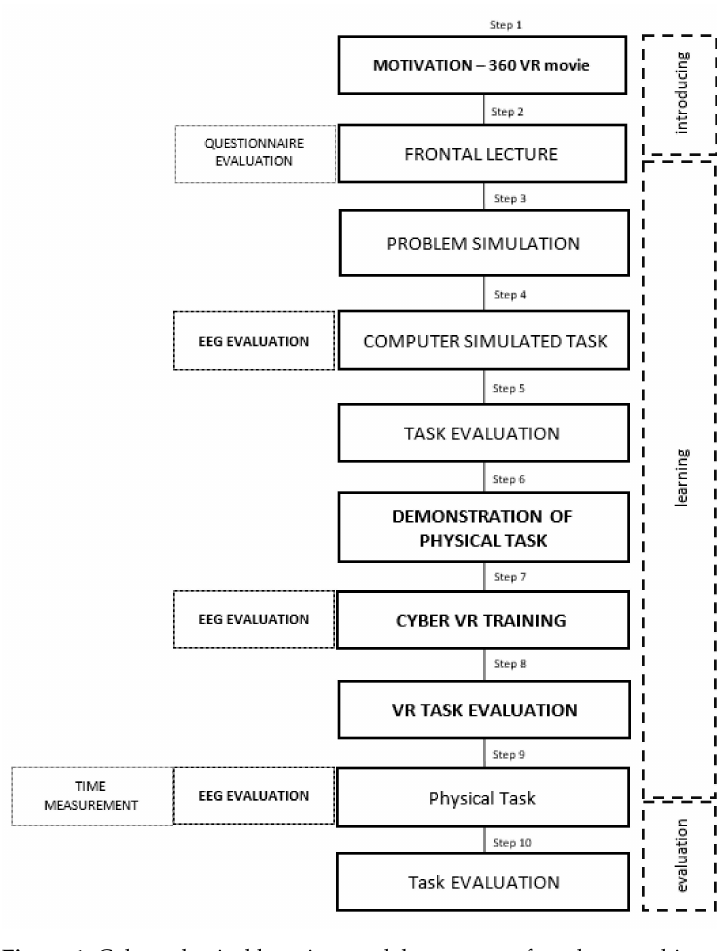
Figure 1. Cyber–physical learning model—concept of modern teaching model.